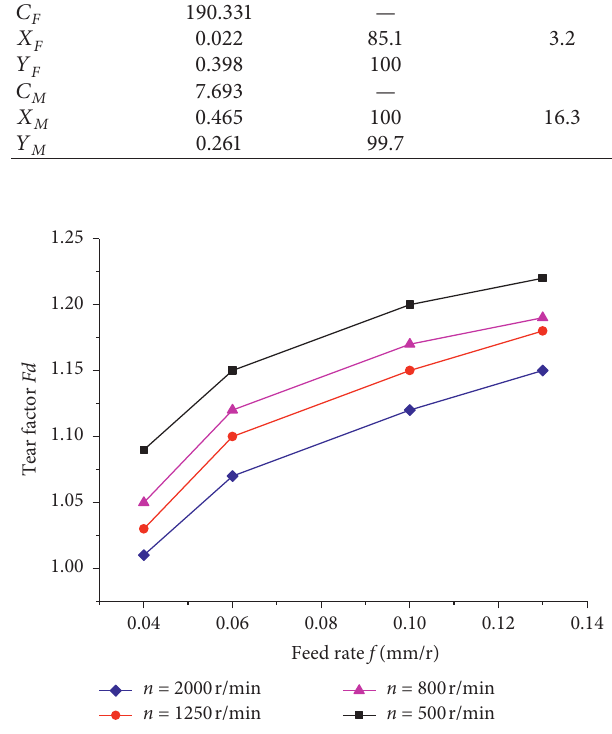
Figure 23: Tear factor Fd at the varying experimental parameter